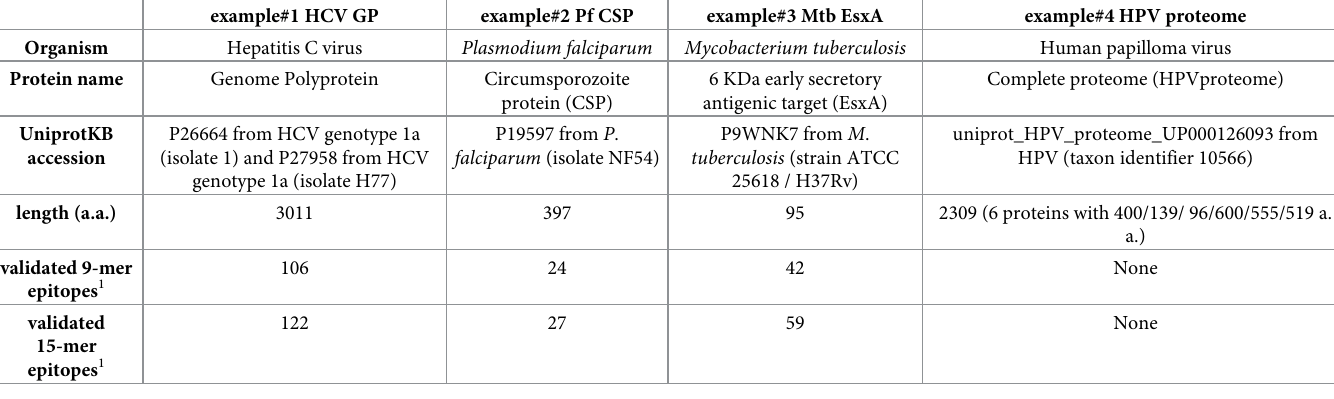
Table 1. Example proteins and validated epitopes present in the IEDB 3.0 database.